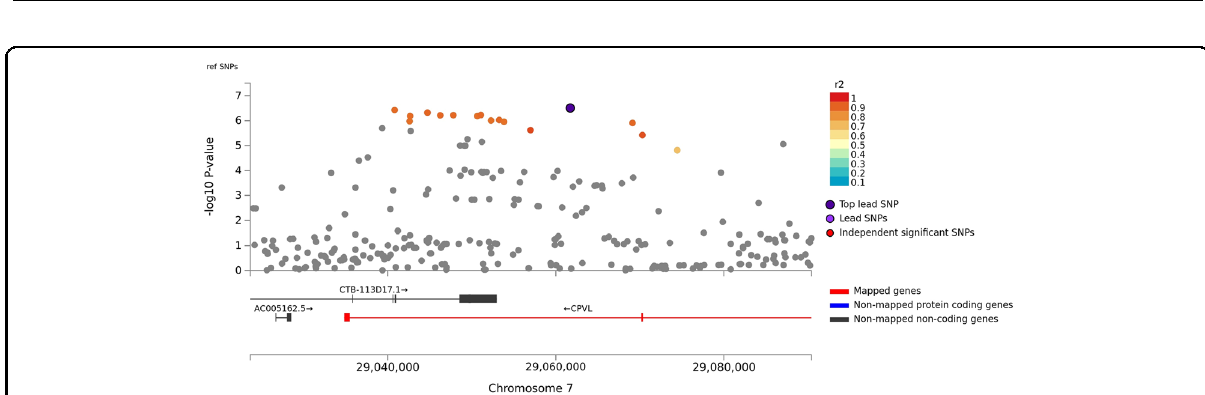
Fig. 5 Association of stimulant dependence with SNPs located in the CPVL region in the combined African American and European ancestry discovery sample. SNPs are color-coded according to the correlation coef fi cient ( r 2 ) in the 1000 Genomes combined European and African reference panels with the top-ranked SNP, rs116441240. Rs116441240 was nearly genome-wide signi fi cant ( P = 3.05 × 10 − 7 ) after meta- analysis with the replication sample.